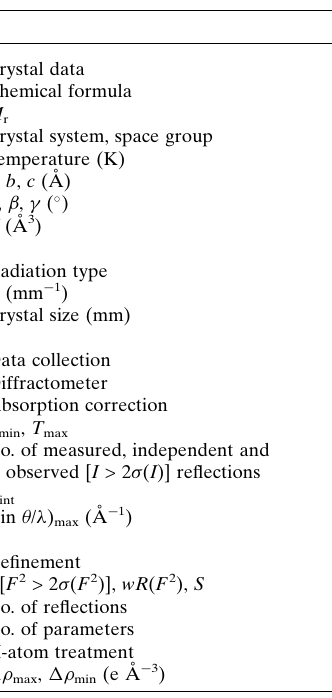
Table 4 Experimental